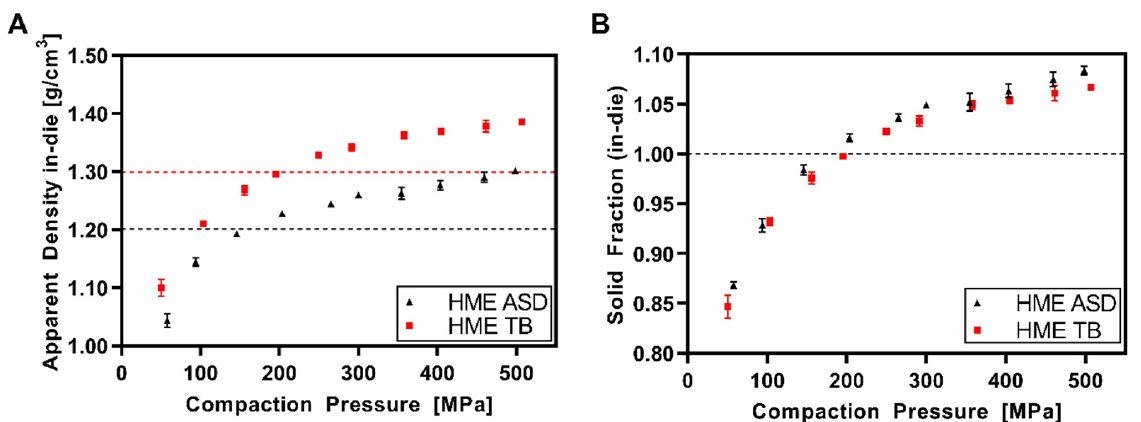
Figure 4. HME ASD and HME TB: ( A ) apparent density in-die vs. compaction pressure (dotted lines = respective particle densities); ( B ) solid fraction in-die vs. compaction pressure.